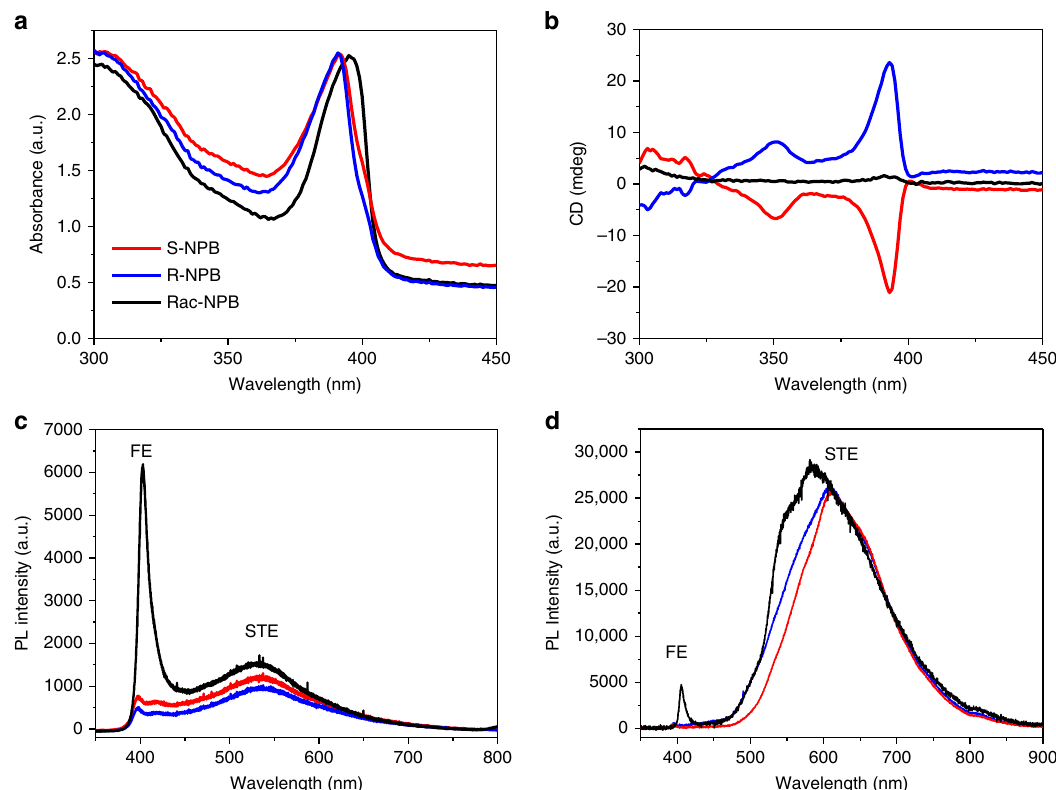
Fig. 2 Optical properties of chiral- and racemic-NPB. a UV – Vis linear absorption spectra and b circular dichroism (CD) spectra recorded at room-temperature for thin fi lms of racemic-, R - and S -NPB. c , d Photoluminescence spectra from single crystals of racemic-, R - and S -NPB obtained at c room-temperature using a 325nm laser source, and at d 7K using a 266 nm laser source; FE and STE denote free excitons and self-trapped excitons,